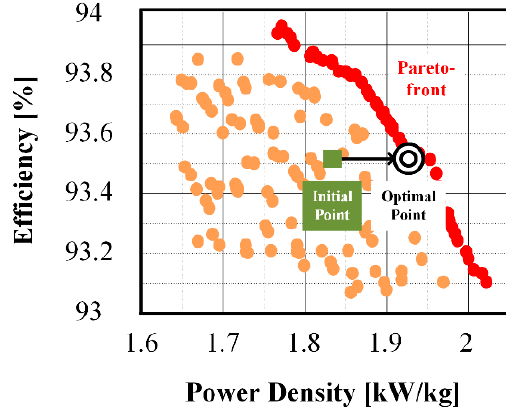
Figure 7. Pareto-front of power density, efficiency.